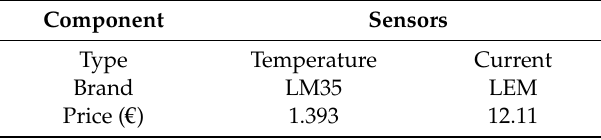
Table 3. Selected sensors for current and temperature.